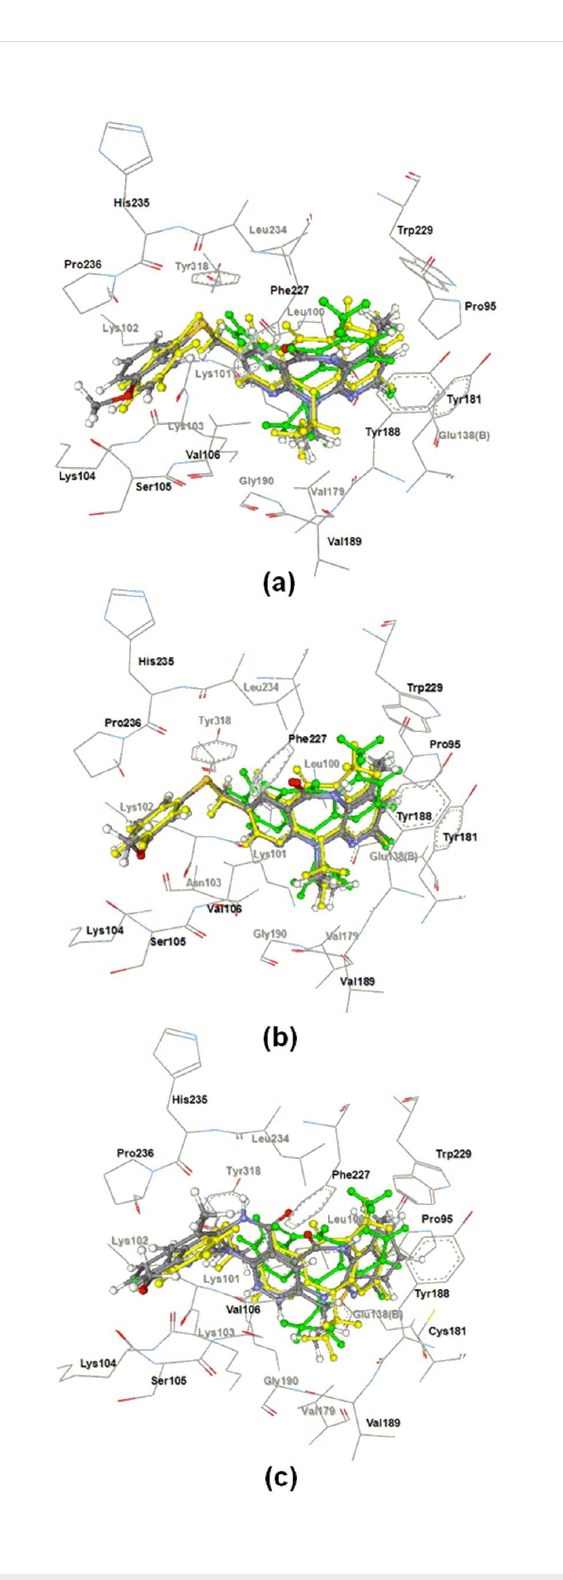
Figure 3: Docked orientations of nevirapine (green), 9 (yellow), 5 , and 6 (atom type color – carbon: grey, chloride: green, hydrogen: white, nitrogen: blue, oxygen: red and sulfur: yellow) in WT (a), K103N (b), and Y181C (c) binding